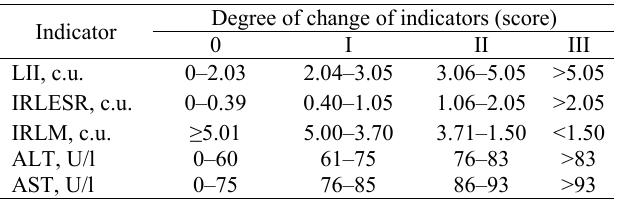
Integral assessment of the level of endogenous intoxication Indicator